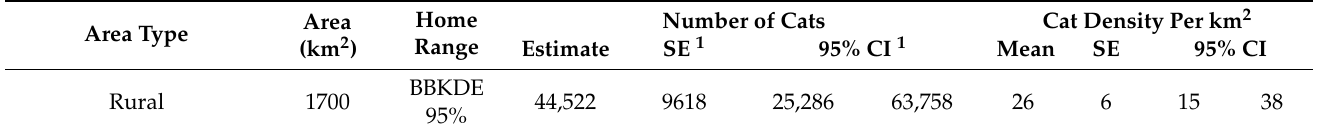
Table 6. Total population numbers in Denmark. Estimates of unowned free-ranging cat population sizes by habitat type and for Denmark as a